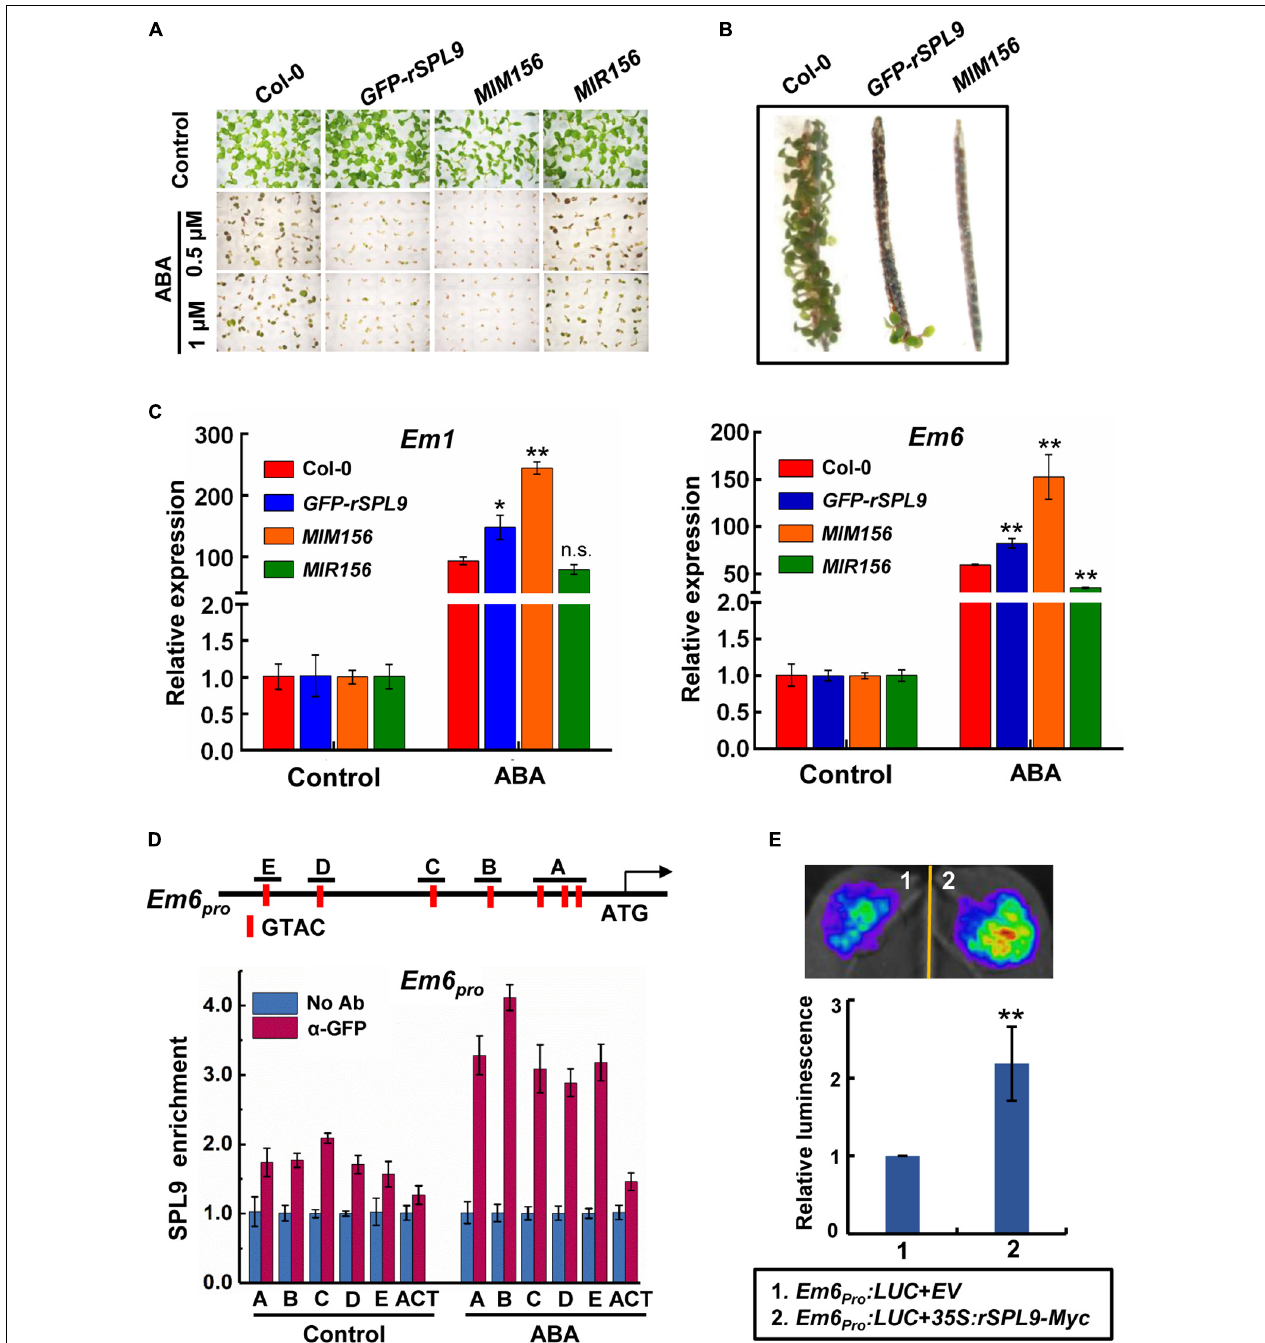
FIGURE 1 | The miR156-targeted SPLs enhance ABA responses. (A) Germination phenotype of the indicated seedlings grown on medium containing 0, 0.5, or 1 µ M ABA for 7 days. (B) Pre-Harvest Sprouting phenotype of the indicated genotypes in fresh mature siliques. (C) qRT-PCR assays showing the expression patterns of ABA-responsive genes in 4-day-old seedlings of indicated genotypes with 10 µ M ABA treatment (4 h ABA treatment for Em1 ; 2 h ABA treatment for Em6 ). The expression levels in untreated seedlings (Control) for each genotype were set to one. Data are means ± SD ( n = 3). Asterisks indicate significant differences between the Col-0 and transgenic seedlings. * P < 0.05, ** P < 0.01, n.s. indicates no significant difference (Student t -test). (D) Chromatin immunoprecipitation (ChIP)-qPCR assays showing the enrichment of SPL9 at the Em6 promoter regions. The vertical red lines in the upper panel indicate the positions of SBP-box binding core motifs. The 6-day-old GFP-rSPL9 seedlings treated without (Control) or with 50 µ M ABA for 2 h were harvested for ChIP assays. Error bars denote ± SD ( n = 3). ACT7 was used as a control. (E) Transient expression assays illustrating the activation of Em6 promoter by SPL9. Upper panel shows a representative leaf image, and the column diagram represents relative luminescence intensities ( n = 15). The mean value in combination one was set to one. ** P < 0.01, (Student’s t -test).